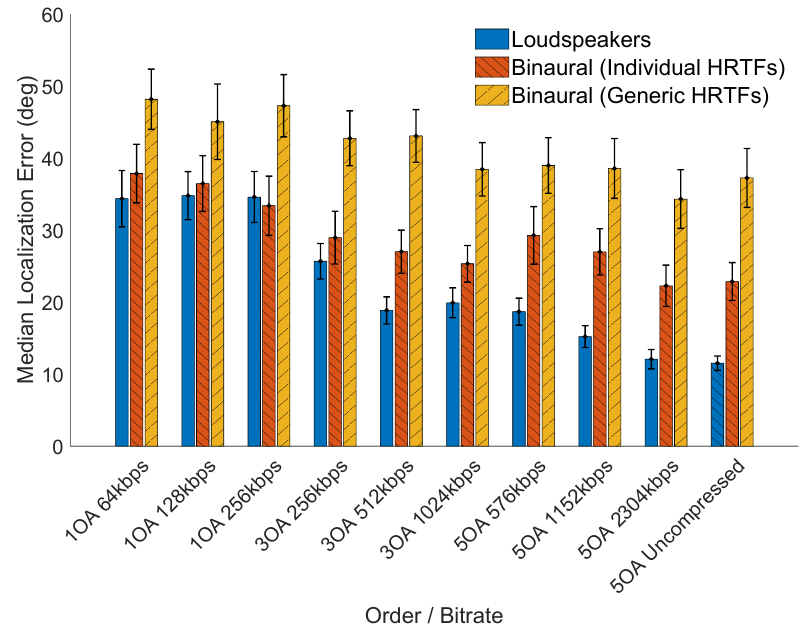
Figure 8. Median localization error at different codec bitrates/Ambisonic orders. The whiskers indicate non-parametric 95% confidence intervals